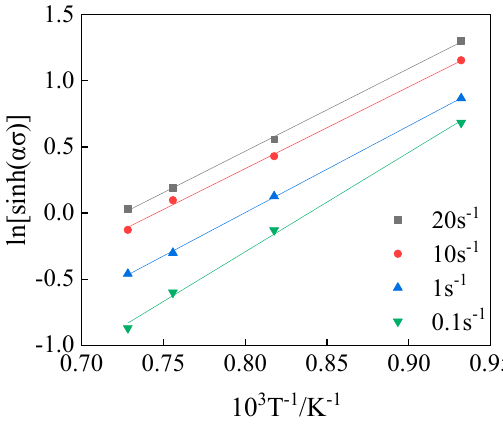
Figure 6. The relation curve of ln𝜀(cid:4662) − ln(cid:4670)sinh(𝛼𝜎)(cid:4671) .